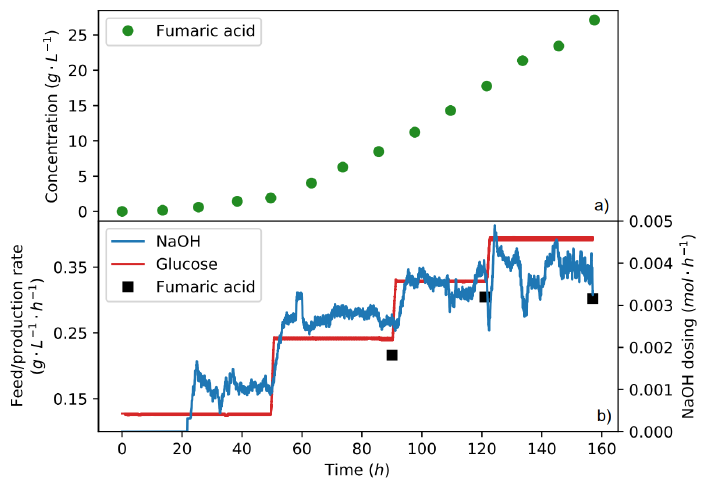
Figure 1. An illustration of how stable acid production was determined and how concentration pro- files were used to determine volumetric rates of production. ( a ) The HPLC fumaric acid concentration profile taken from the reactor. This is data from a single fermentation. ( b ) A comparison between the glucose feed rate and the rate of NaOH dosed to maintain the pH. The fumaric acid production rates calculated from the HPLC concentrations and the dilution rate are also shown (black squares).